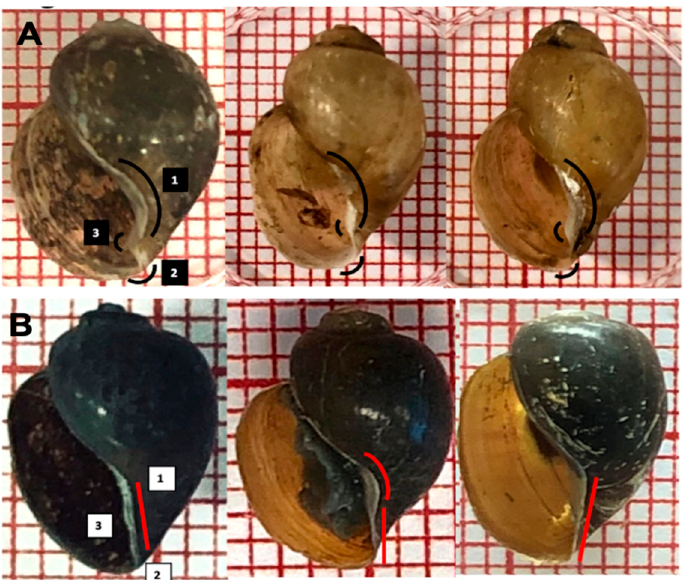
Figure 7. Subtle morphological differences in truncated columella region, a notch or ‘tooth’, in the aperture of B. globosus. ( A ): (1) curved columellar edge, (2) basal margin join, (3) distinctive notch on the inside; ( B ): shells and other B. africanus group (1 square = 1 mm 2 ).